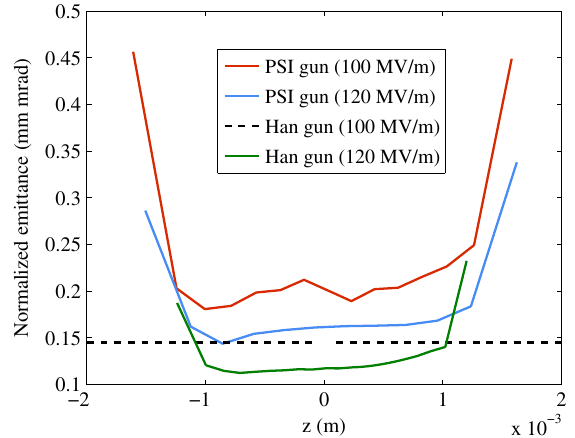
FIG. 9. Emittance along the bunch for the coaxial coupler design and the PSI gun case. The Han gun was optimized assuming 120 MV = m for the gun gradient. For comparison the expected mean emittance along the bunch for 100 MV = m is also indicated (dashed line). 910 nm = mm is assumed in these